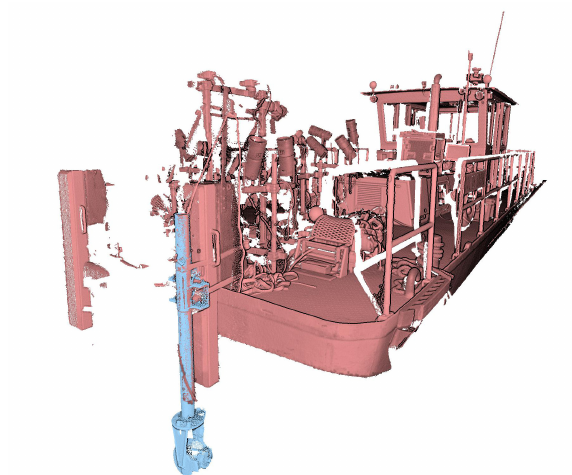
Figure 7. Full-set-up point cloud obtained by laser scanning with in red the above-water part of the system and in blue the aligned sonar point cloud.